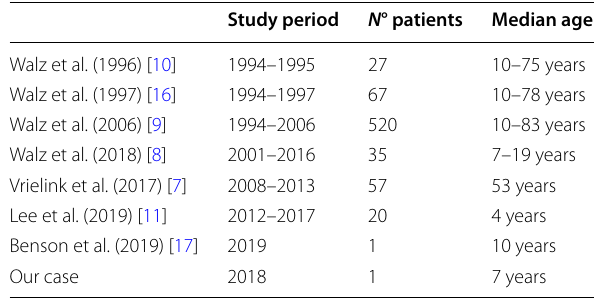
Table 1 Posterior retroperitoneoscopic approach in adrenal surgery. Literature